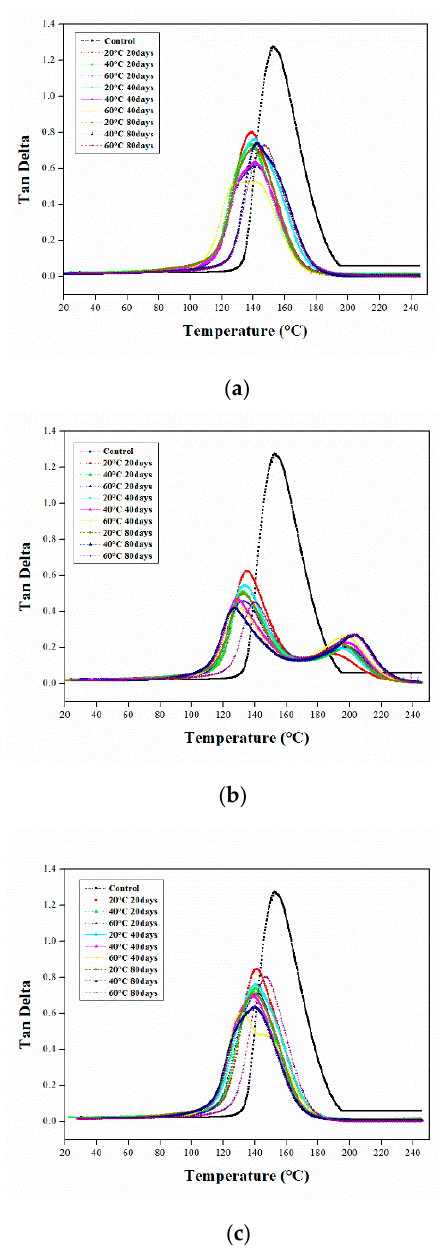
Figure 3. DMA tan delta curves of neat epoxy resins in different immersion temperatures ( ▫ ; control, ◦ ; at 20 °C, Δ ; at 40 °C, +; at 60 °C) for (..; 20 days, -; 40 days, ---;80 days) in various solutions ( a ) Water; ( b ) HCl; and ( c ) NaOH solution.